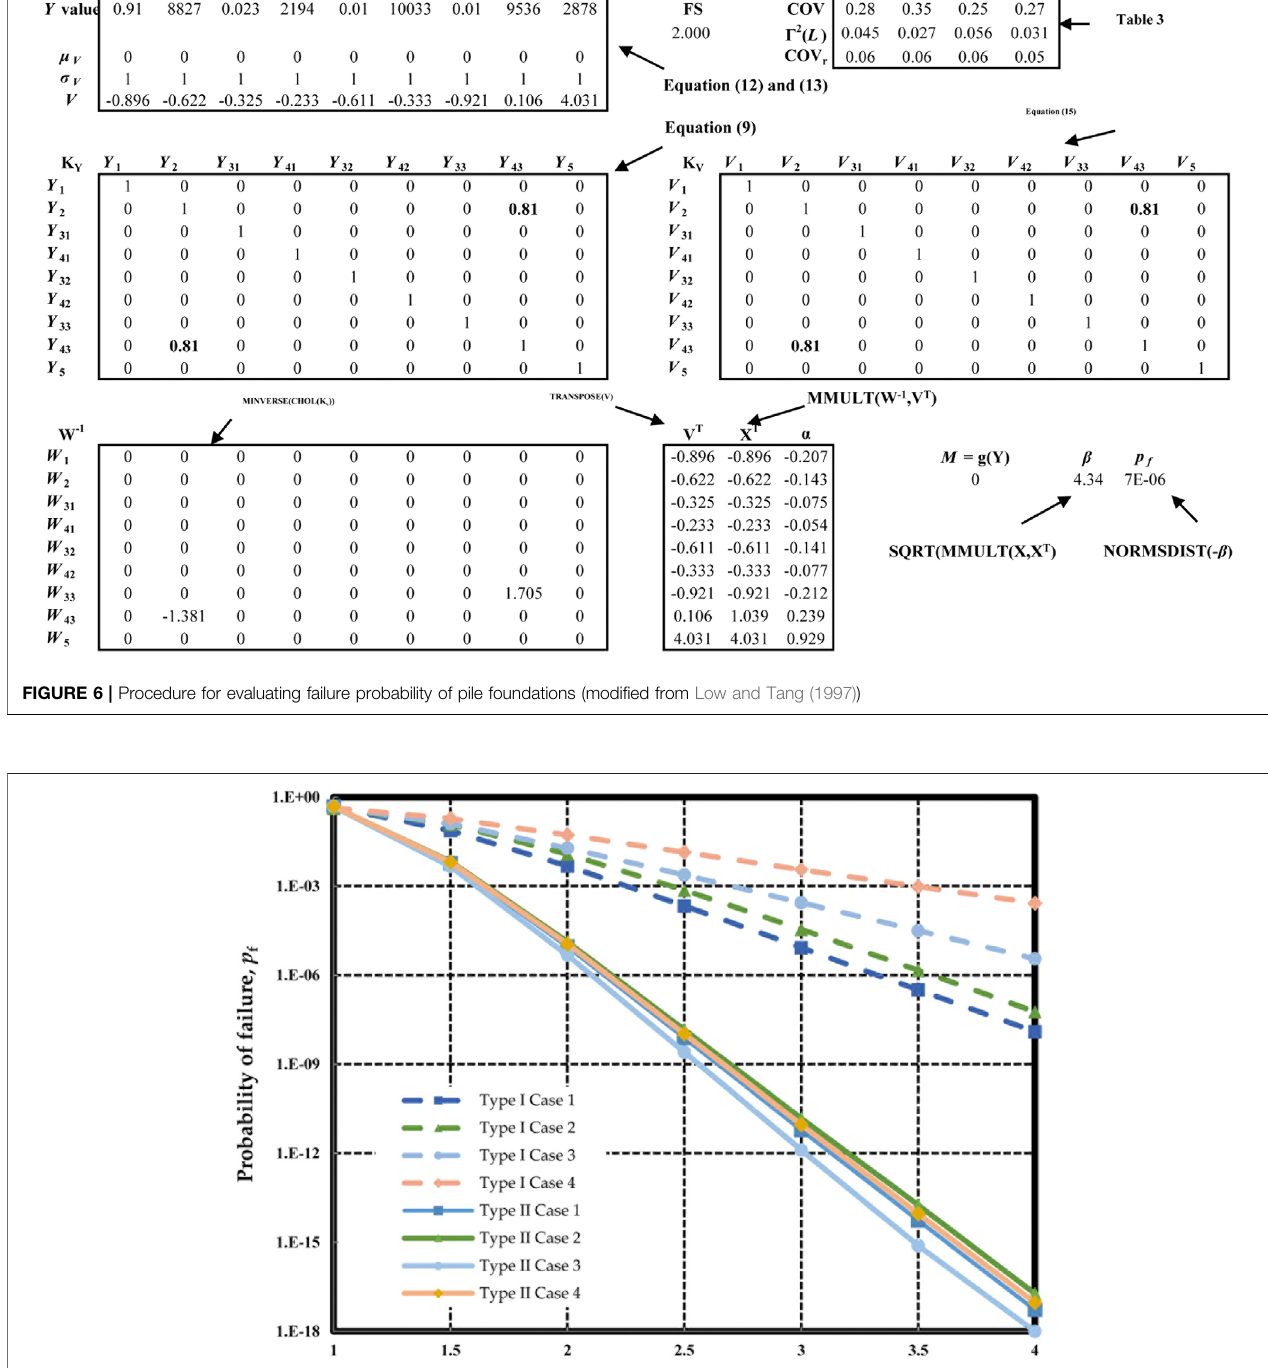
Frontiers in Earth Science |